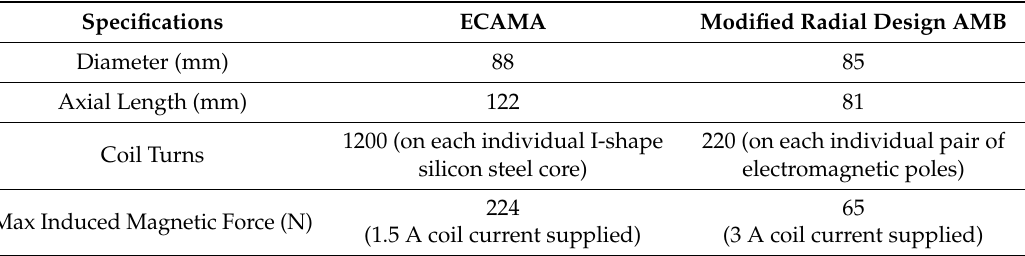
Table 3. Comparison between ECAMA and traditional AMB design.